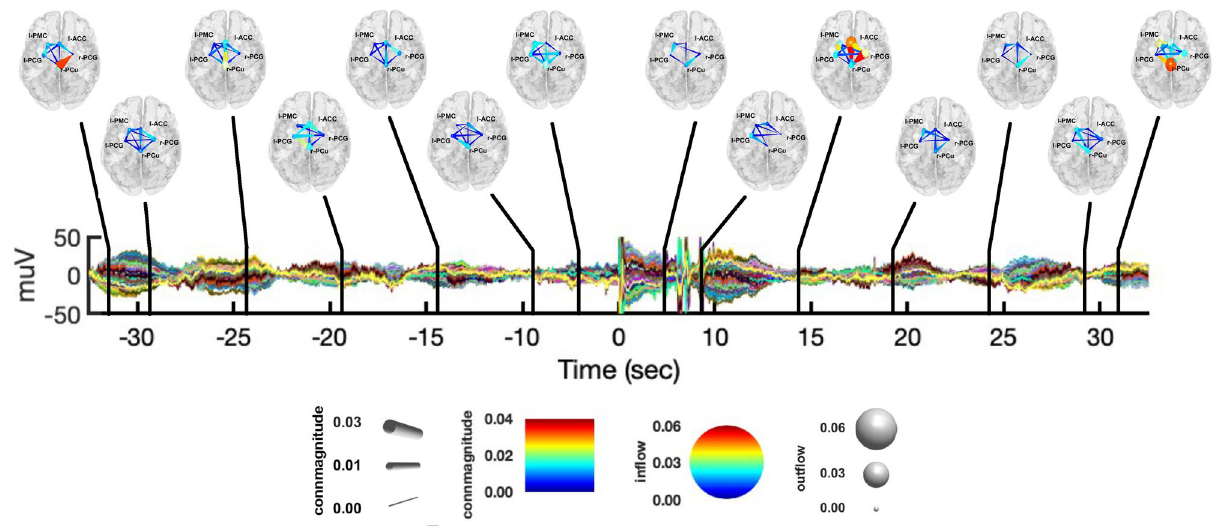
Figure 8. Graphical representation of causal interactions between the network nodes (i.e., l-PCG, l-PMC, r-PCu, l-ACC and r-PCG) integrated in the β and γ bands, during both the resting-state from − 35 to − 5 s and CPT from + 5 to + 35 s, with respect to the CPT start. Nodes are reported in a standard template, with their corresponding label. Node size represent information outflow, whereas node color represents